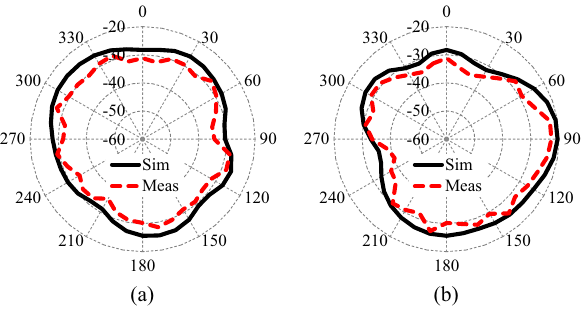
Figure 11. Radiation pattern of the proposed wideband implantable MIMO antenna at 2.45 GHz.